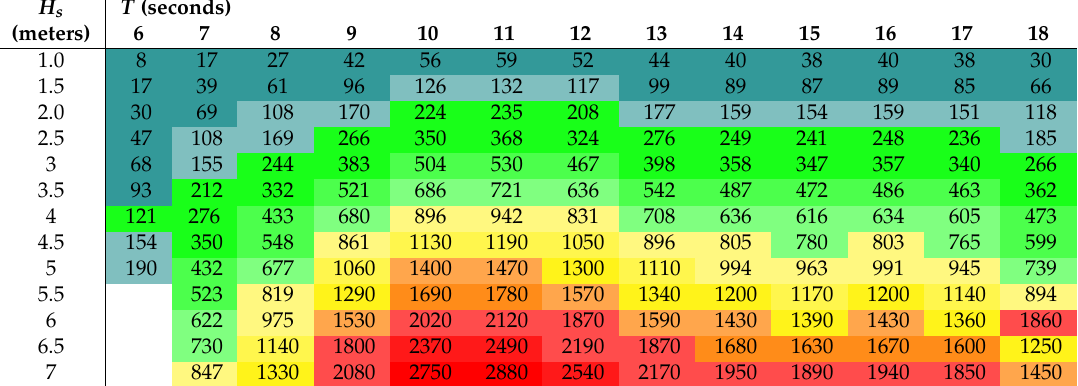
Table 5. Matrix conversion for the floating oscillating water